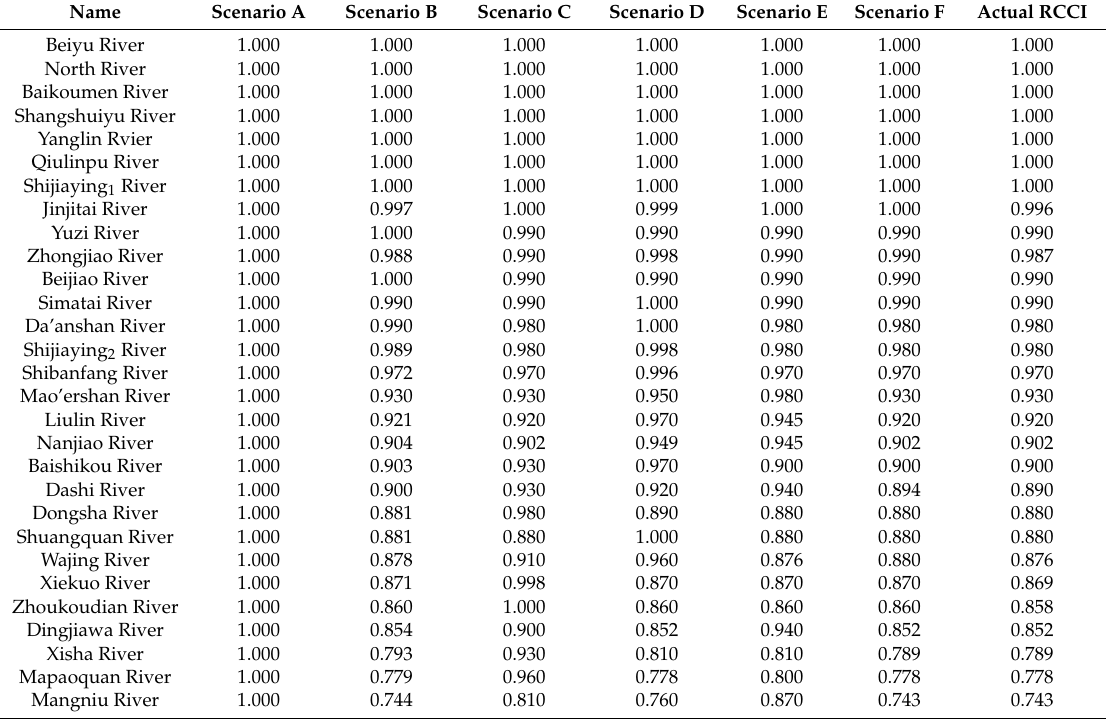
Table 5. RCCI values at different